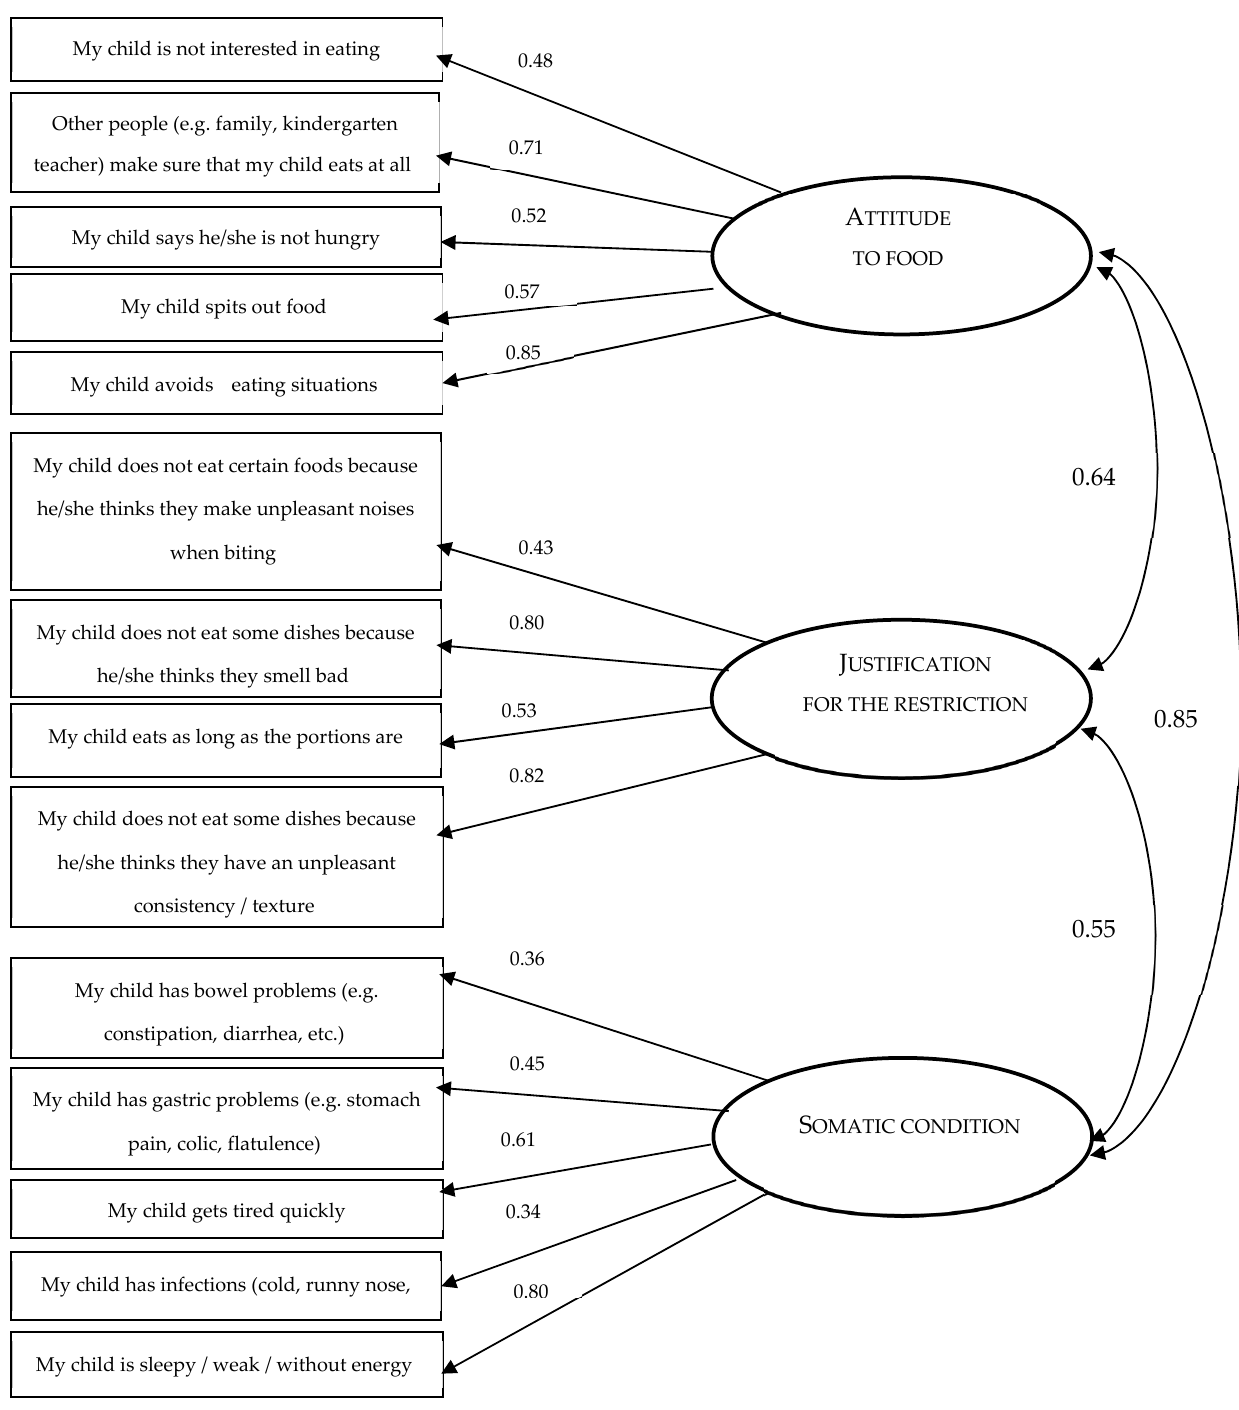
Figure 1. Confirmatory analysis showing the three factors of ARFID-Q-PR.